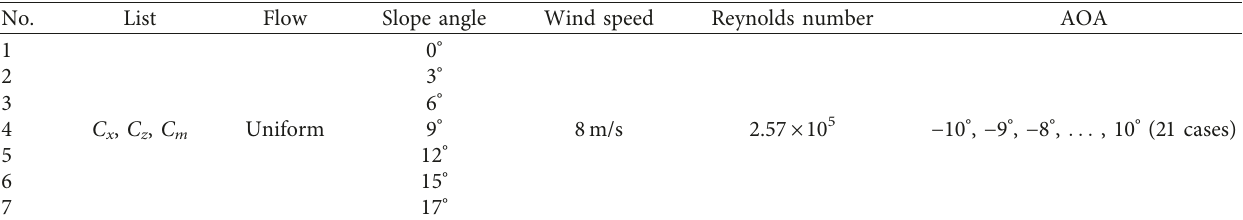
Figure 8: Sign convention of static aerodynamic coefficients. Table 2: Wind tunnel test cases.